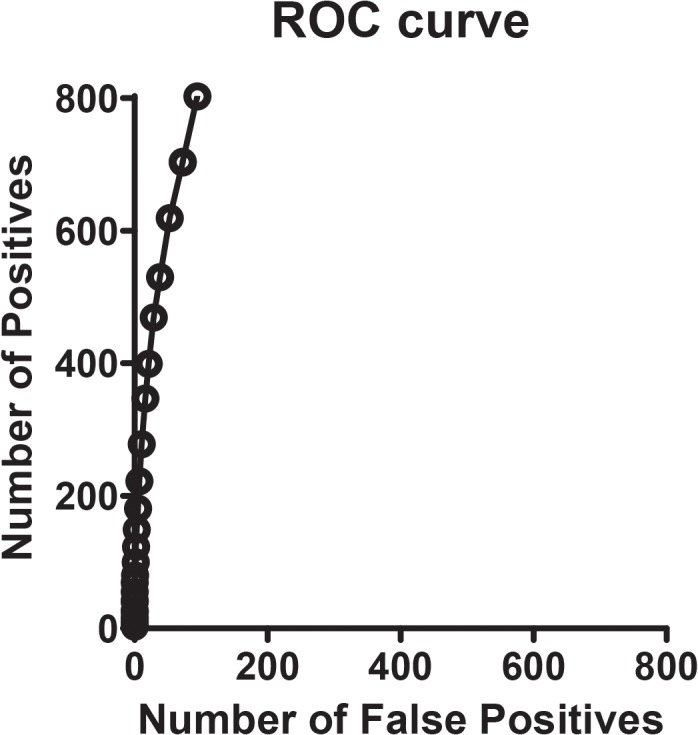
Receiver-operator curves (ROC) for cross-sectional study (Cohort-1).Comparison of the AD samples versus the control samples was used to estimate the sensitivity, while the comparisons between two groups comprised of randomly selected but equally balanced AD and control samples were used to estimate specificity.